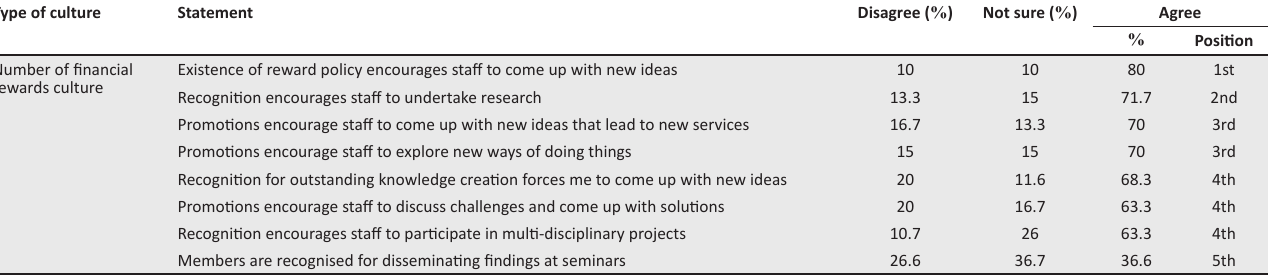
TABLE 1: Percentages for non-financial reward culture and knowledge